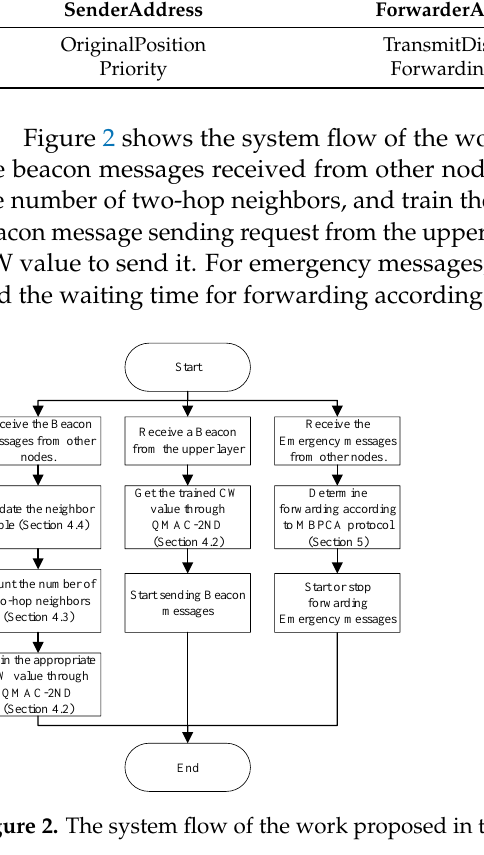
Frame Figure 3. The contention-based MAC protocol process of the WAVE standard.